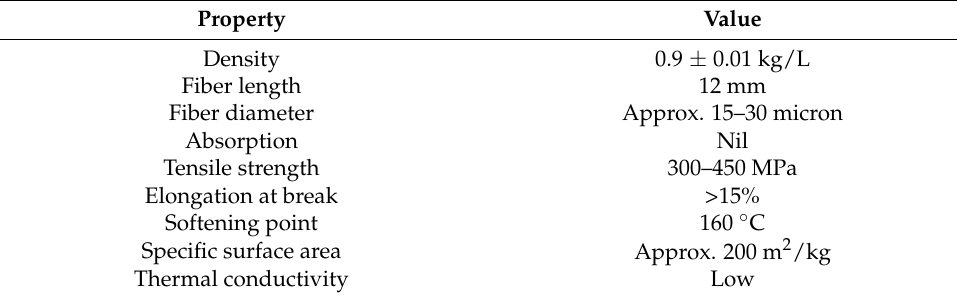
Table 3. Characteristics of polypropylene